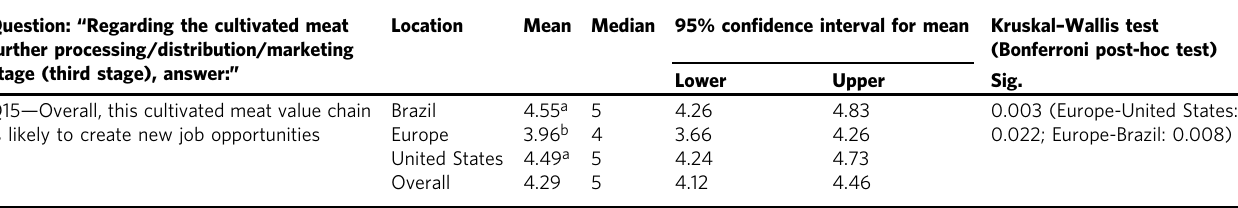
Table 12 Results regarding the impact of the third stage of the cultivated meat value chain on jobs and quali fi cations in Brazil ( N = 35), Europe ( N = 56) and the United States ( N = 45) using Likert scale from 1 (strongly disagree) to 5 (strongly agree), from August to October,